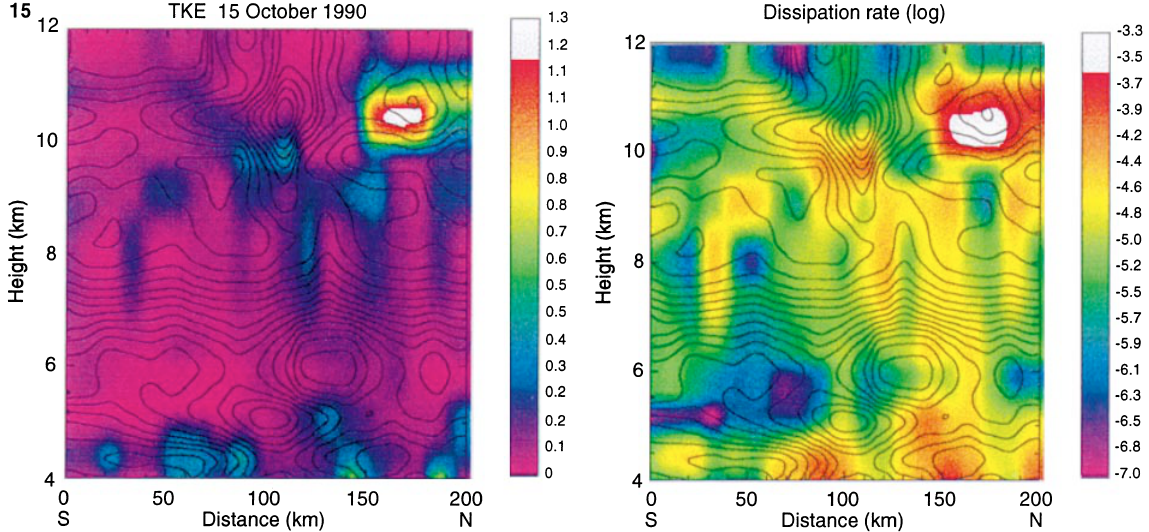
Fig. 15. Colors : TKE (in m 2 s (cid:255) 2 ) ( top ) and decimal logarithm of TKE dissipation rate ( bottom ). The black isolines reproduce the horizontal wind presented in Fig. 8, 15 October